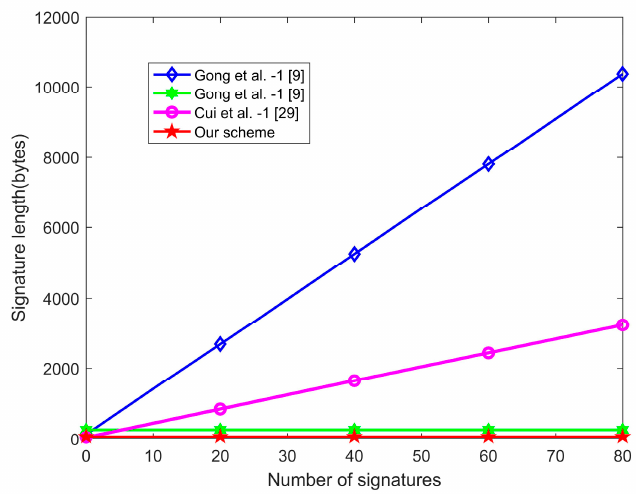
Figure 4. The comparison of signature length.